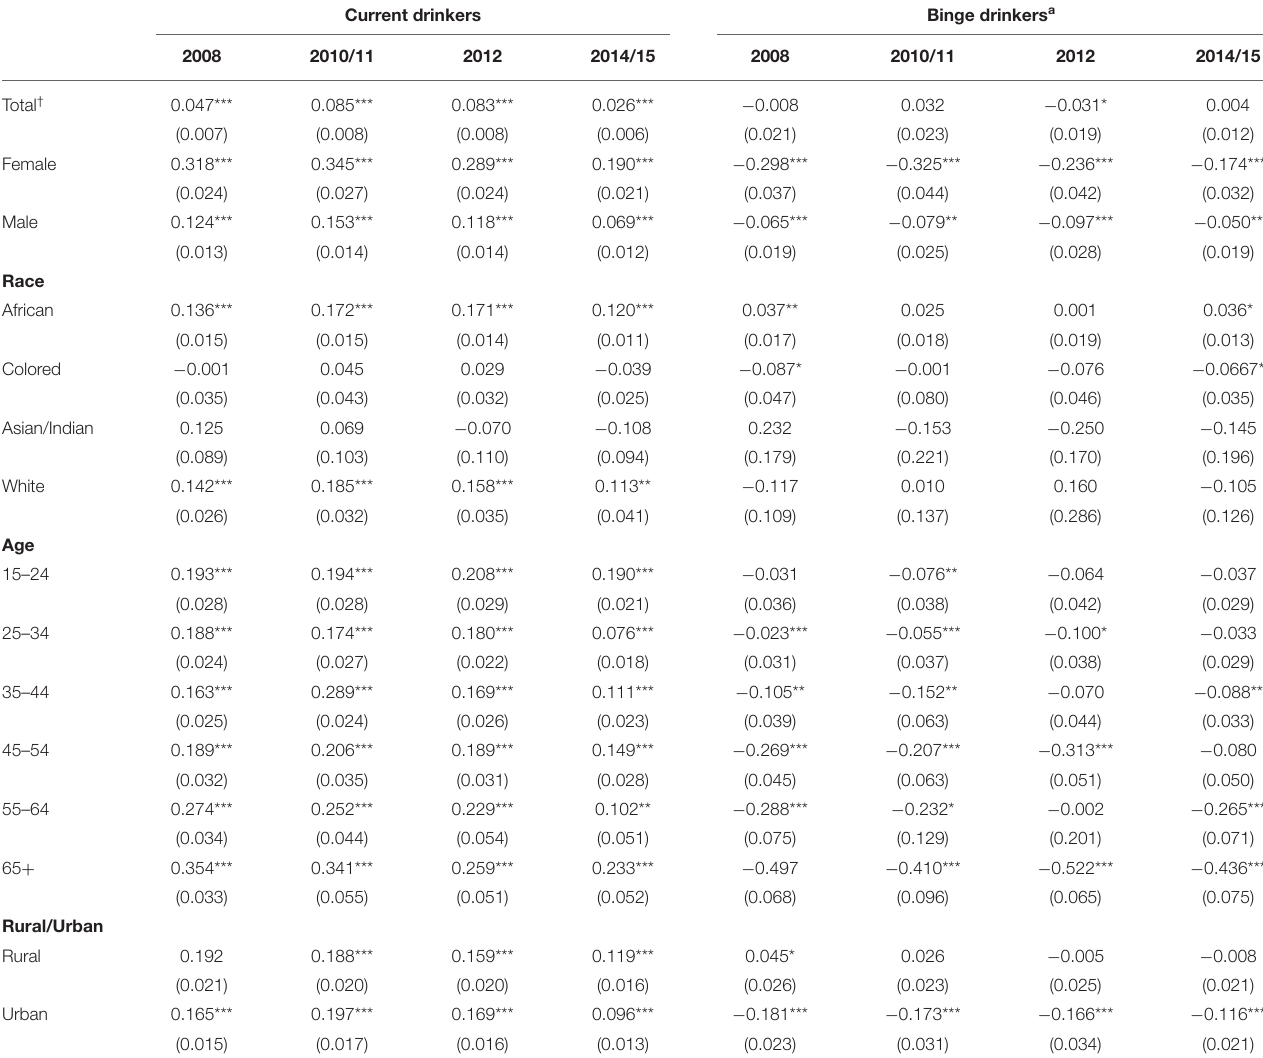
TABLE 5 | Concentration indexes of current drinkers and binge drinkers